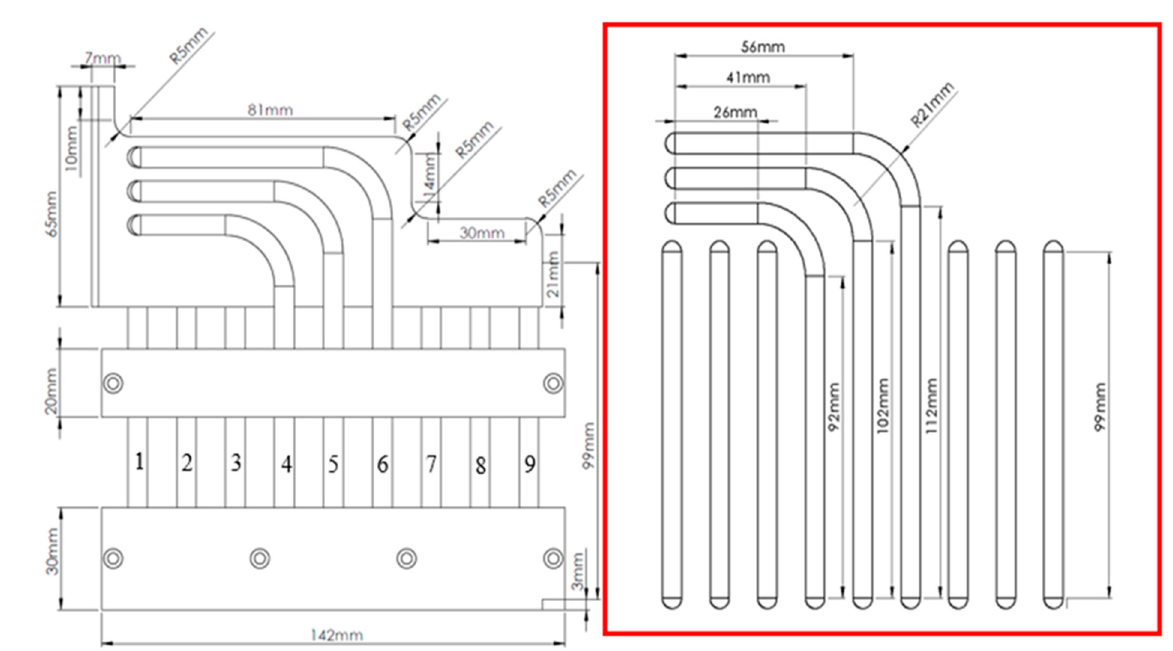
Figure 4. Configuration of Type I cold plate.